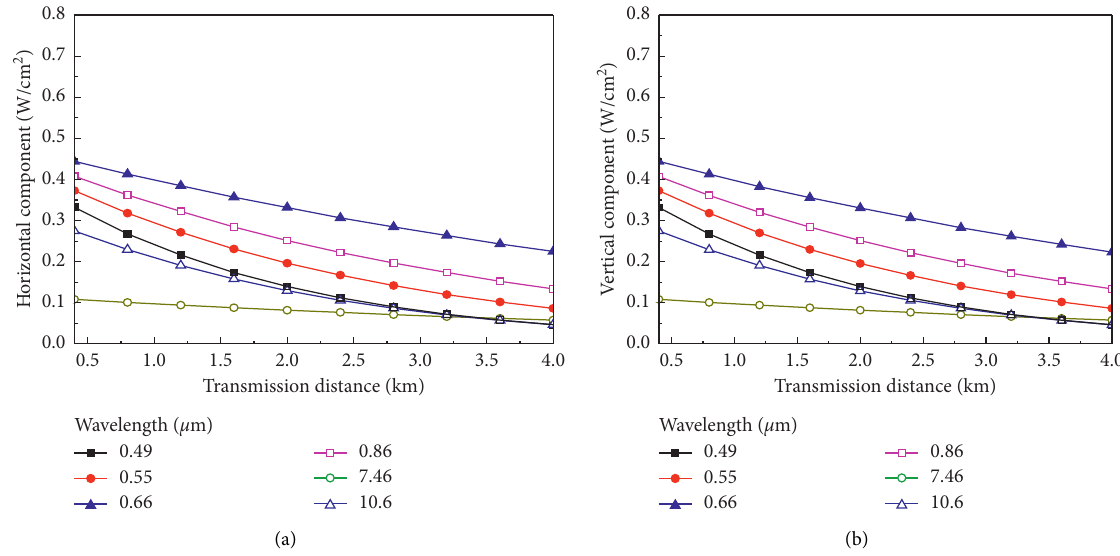
Figure 4: Completely linearly polarized laser [1, 0, − 1, 0] (with an angle of − 45 ° to the scattering plane) transmitted in the Martian dust: (a) horizontal component of completely linearly polarized laser [1, 0, − 1, 0] varying with the transmission distance and (b) vertical component of completely linearly polarized laser [1, 0, − 1, 0] varying with the transmission